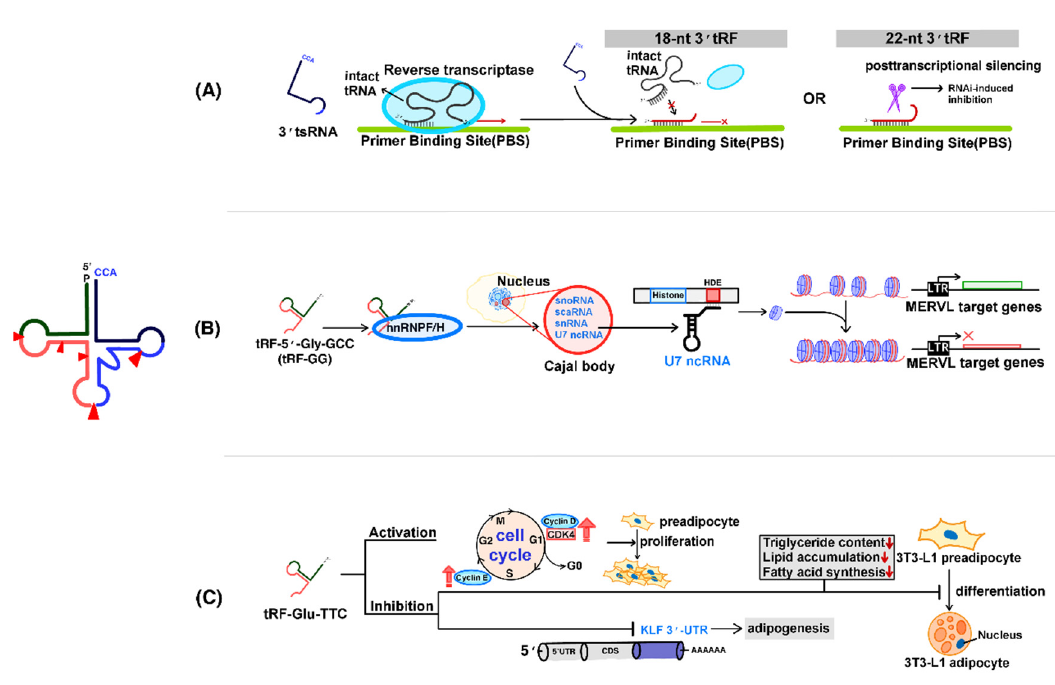
Figure 3. PIWI-independent epigenetic regulation and function of tRNA-derived small RNAs ( A ) Regulation of transposon activity. Intact mature tRNAs play a role as primers during the reverse transcription of ERVs; 3 (cid:48) tsRNAs (18-nt long; red line) interrupt this process by competing for the primer binding site (PBS), whereas 22 nt long 3 (cid:48) tsRNAs induce post-transcriptional silencing of retroviral proteins by targeting their mRNA. ( B ) Regulation of chromatin accessibility; 5 (cid:48) tRF-Gly-GCC (tRF-GG) directly binds to heterogeneous nuclear ribonucleoproteins F and H (hnRNP F / H), thereby forming a complex. This complex is required for the biogenesis of a normal Cajal body. Further, U7 snRNA is required for histone expression by base pairing with the histone downstream element (HDE). Consequently, elevated histone levels a ff ect the expression of MERVL-associated genes via altering the chromatin status (euchromatin to heterochromatin). ( C ) Regulation of adipogenesis. Increased levels of tRF GluTTC induce the expression of several cell cycle regulatory factors, such as Cyclin D1, CDK4, and Cyclin E, thereby promoting preadipocyte proliferation, while inhibiting 3T3-L1 preadipocyte di ff erentiation. tRF GluTTC –mediated inhibition results in reduced expression of fatty acid synthesis-related genes and a decrease in triglyceride content and lipid accumulation. Finally, increased levels of tRF GluTTC inhibit result in the inhibition of mRNA translation of Krüppel-like factor (KLF) family members through hybridization to KLF 3 (cid:48)